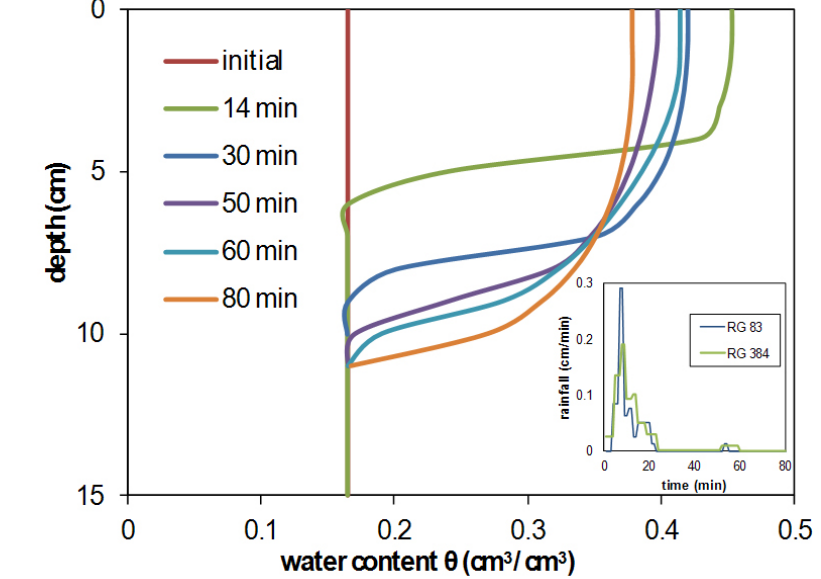
Figure 5. Model sensitivity to a ±10% change of the calibrated parameters for two selected episodes. F for channel and overland flow respectively.